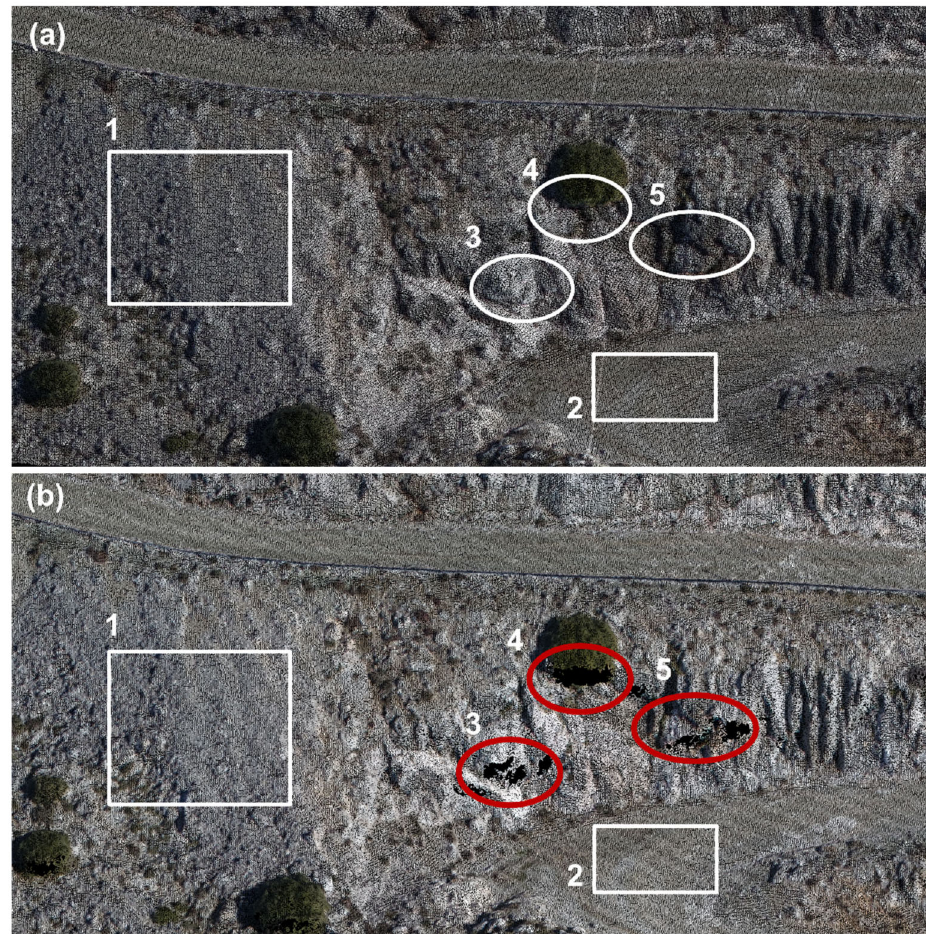
Figure 10. Dense point cloud: ( a ) produced from case A, ( b ) produced from case